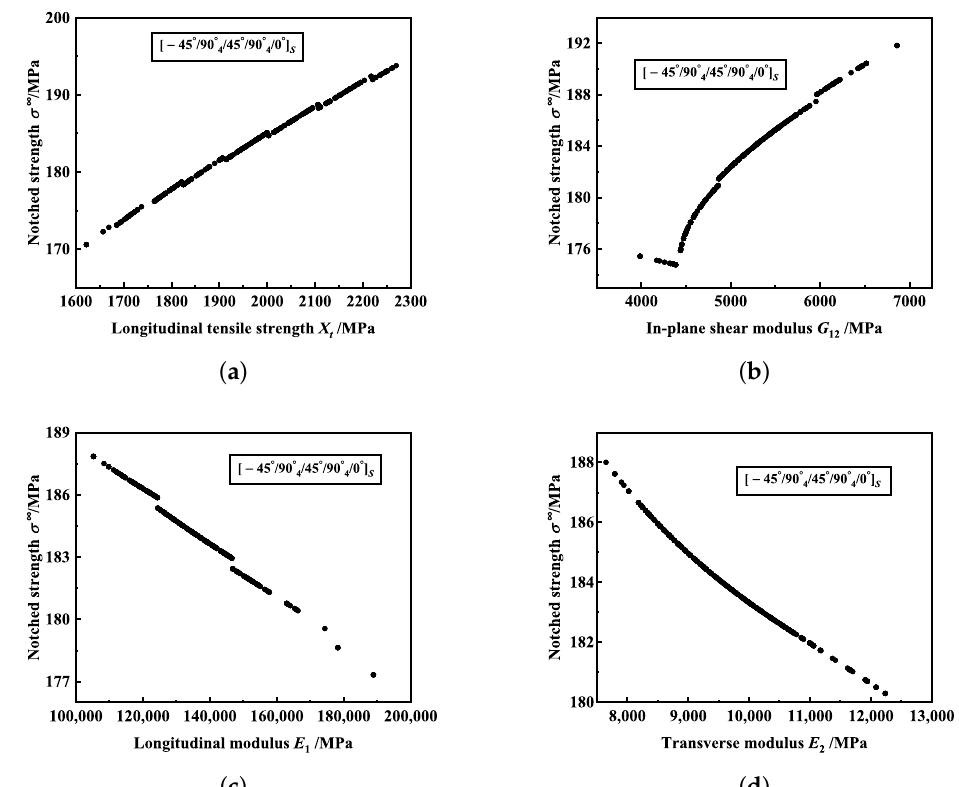
Figure 7. The influence of material properties on the tendency of failure strength for notched laminate (cid:2) − (cid:3) with 45 ◦ /90 ◦ /45 ◦ /90 ◦ /0 ◦ and 2 R = 3.81 mm: ( a ) Longitudinal tensile strength X t . ( b ) In-plane 4 4 s shear modulus G 12 . ( c ) Longitudinal modulus E 1 . ( d ) Transverse modulus E 2